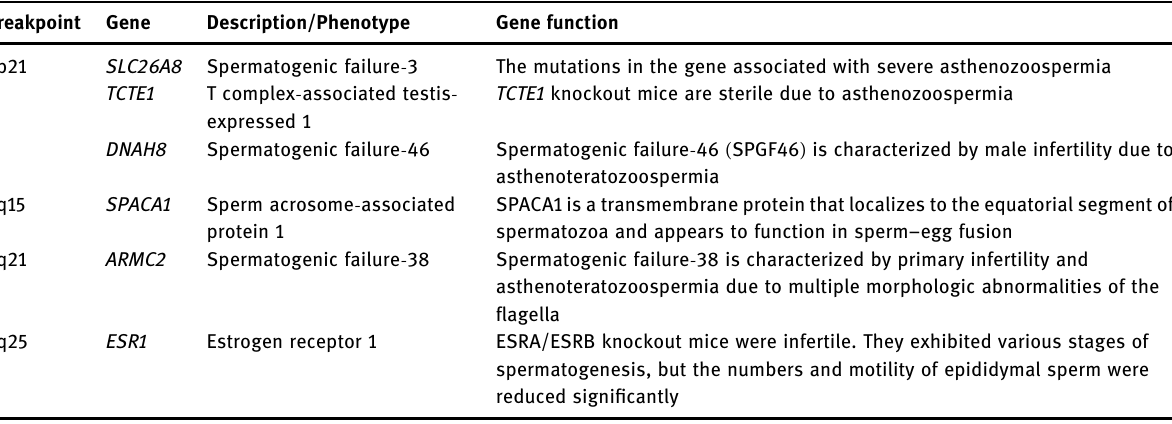
Table 2: Breakpoints and genes related to sperm function on chromosome 6 Breakpoint